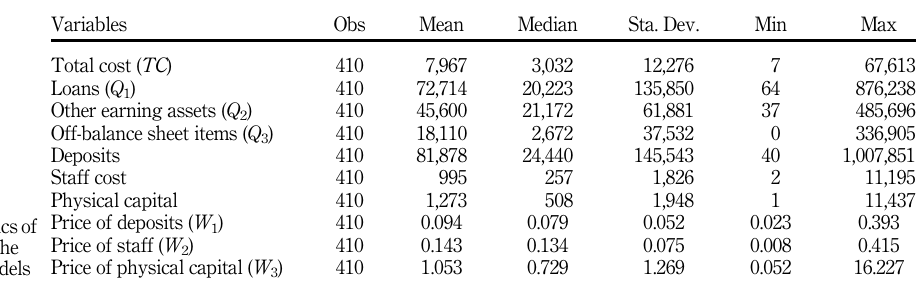
variables used in the DEA and SFA